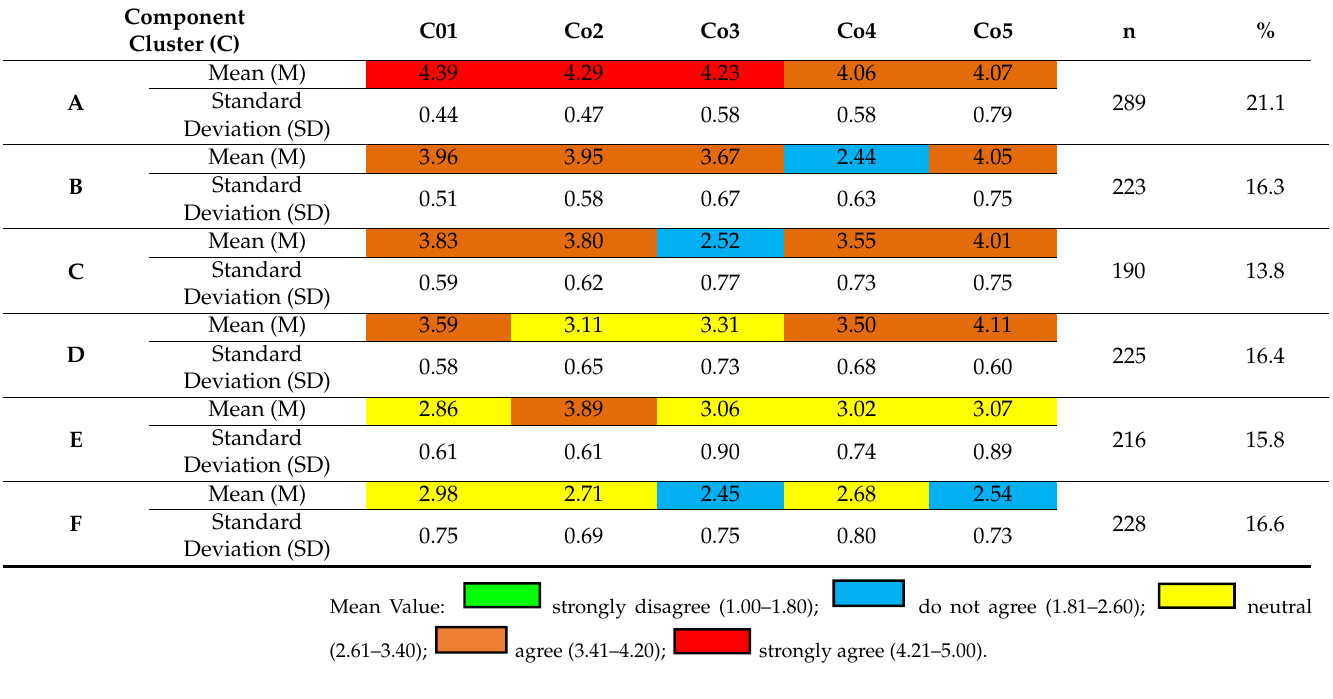
Table 4. Challenges of virtual learning based on clusters.